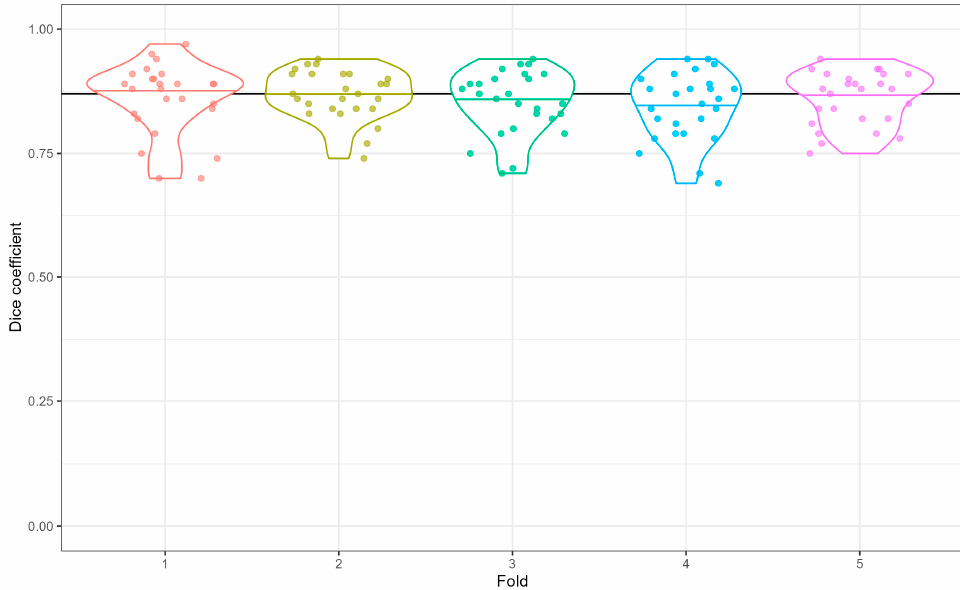
Figure 5. Distribution of Dice coefficients, measuring the performance of our CNV segmentation algorithm, each point represents the Dice coefficient for one image in a particular fold. The violins show the distribution. Coloured horizontal lines mark the median D Dice coefficient within one-fold; the black line is the median overall.